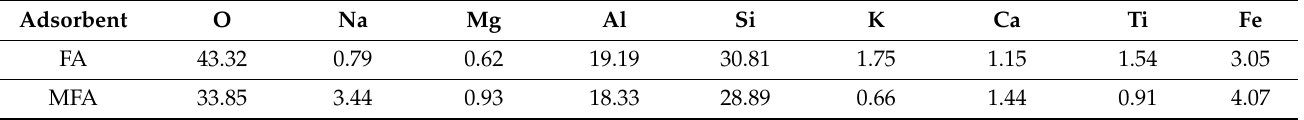
Table 2. The chemical composition determined by SEM/EDS (mass%) .